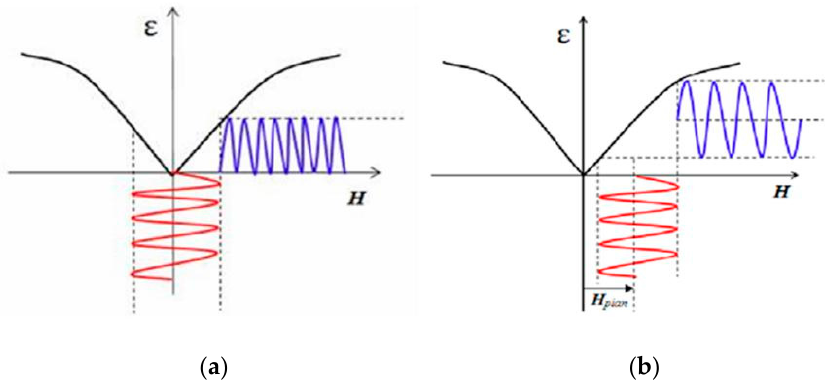
Figure 4. Influence of frequency doubling on magnetostrictive materials. ( a ) “frequency doubling” phenomenon. ( b ) no “frequency doubling” phenomenon.